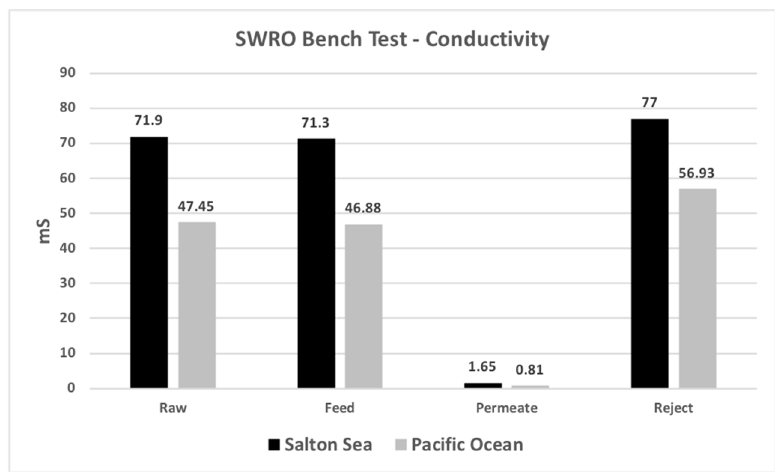
Figure 9. Conductivity of raw water, SWRO feed, permeate, and reject flow.